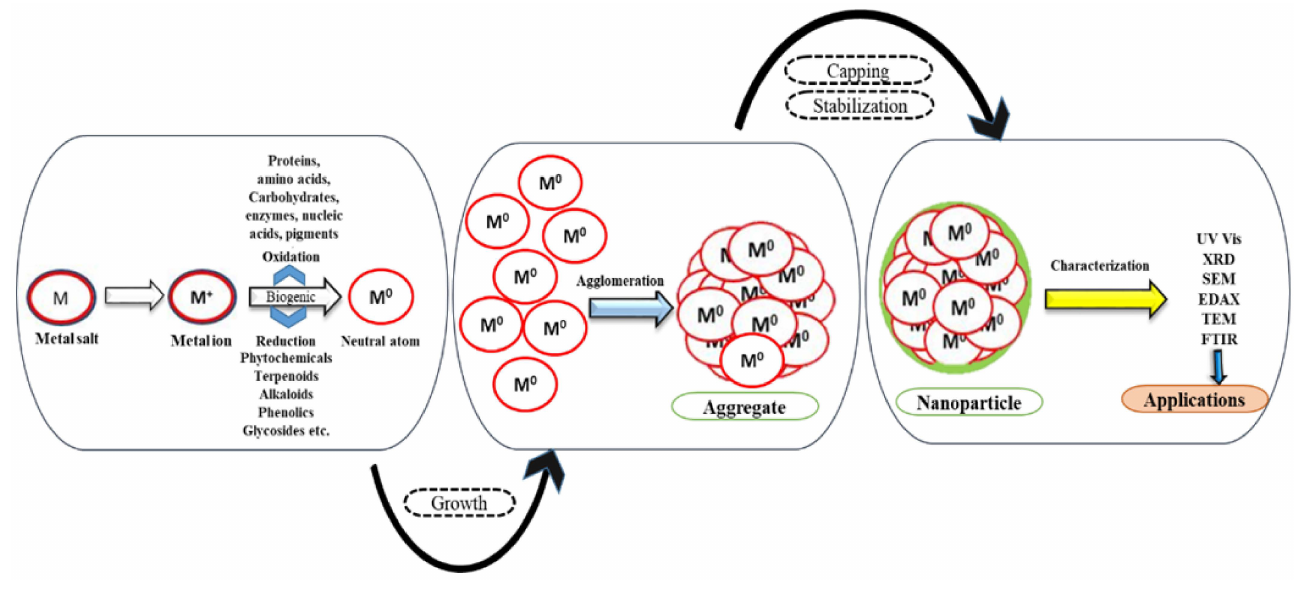
Figure 2. Biological reduction of